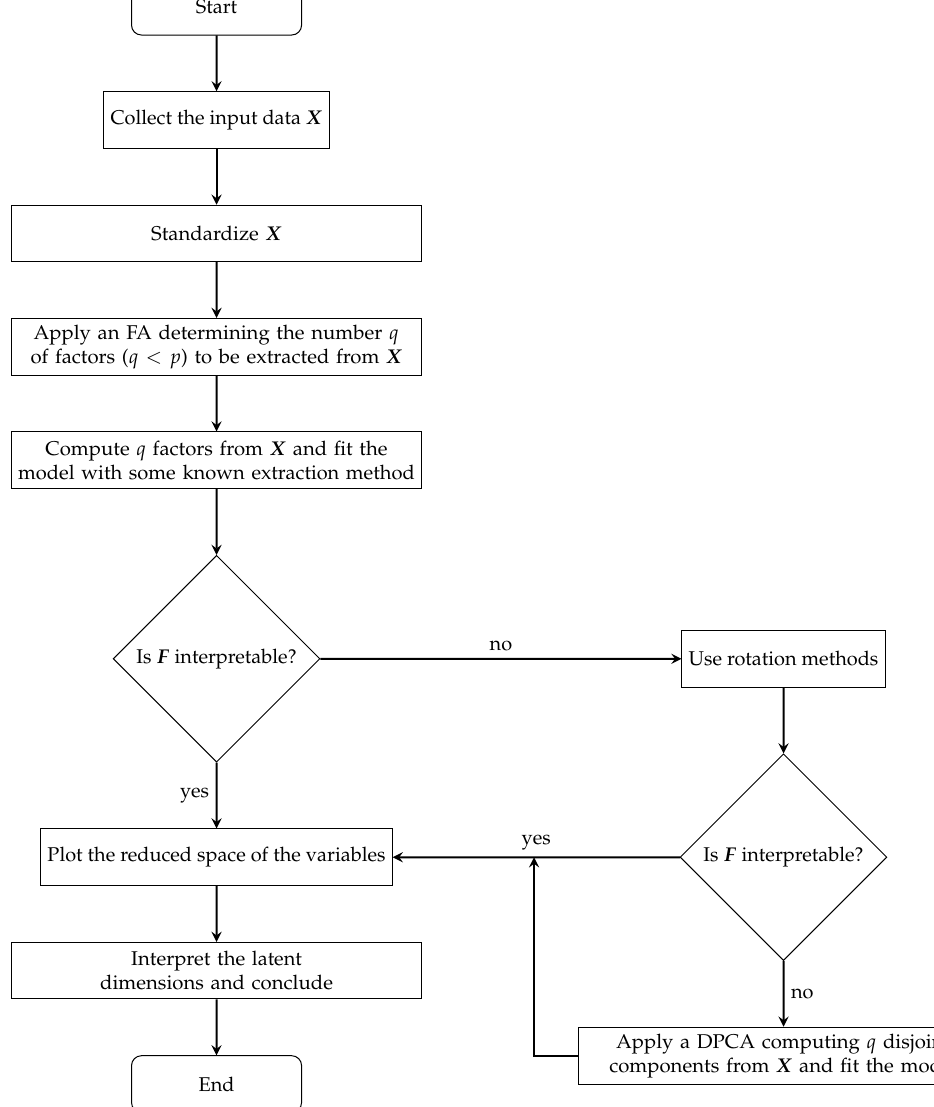
Figure 1. Flow diagram of the methodology for dimension